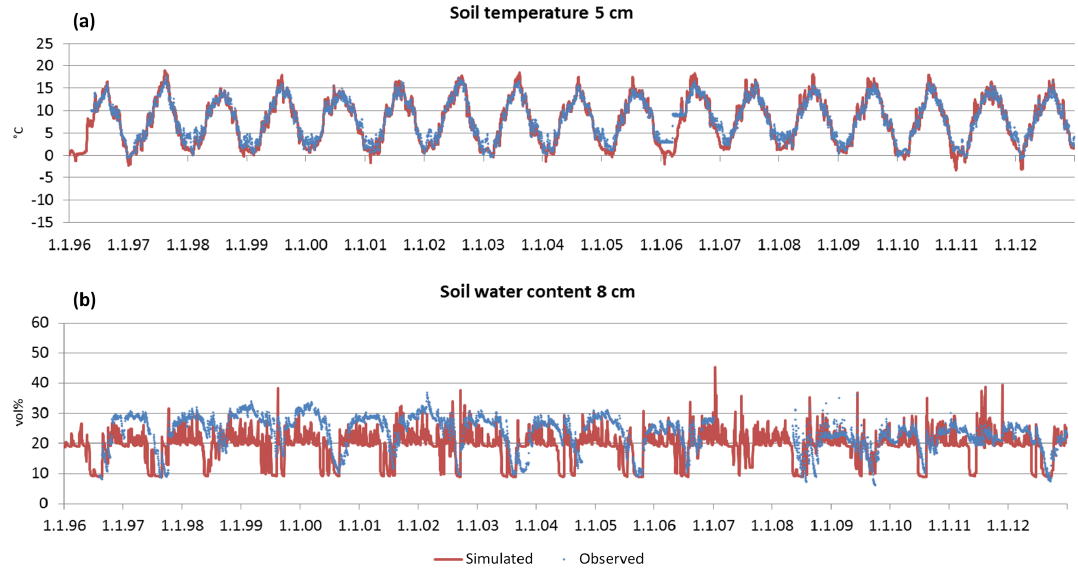
Figure 9. Time series of observed and simulated daily soil temperature at 5cm of depth (a) and time series of observed and simulated daily soil water content at 8cm of depth (b) in Sorø for the period 1996–2012. Table 6. Daily and monthly statistics of soil temperature (ST) and soil moisture (SWC) for Sorø 1996–2012 and Hyytiälä (1996–2014). Daily Monthly